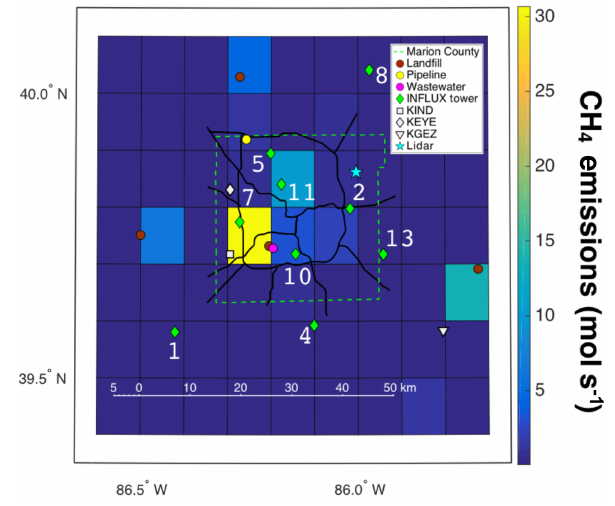
Figure 2. Map of the primary roads in Indianapolis, INFLUX towers, lidar system, weather stations, and a few CH 4 point sources plotted over the gridded CH 4 emissions (mols − 1 ) from the EPA 2012 inventory (Maasakkers et al., 2016). The gridded map of emissions includes emissions from the mentioned point sources; their position is provided to aid in interpretation of the observations. The dashed bright green line denotes Marion County borders.